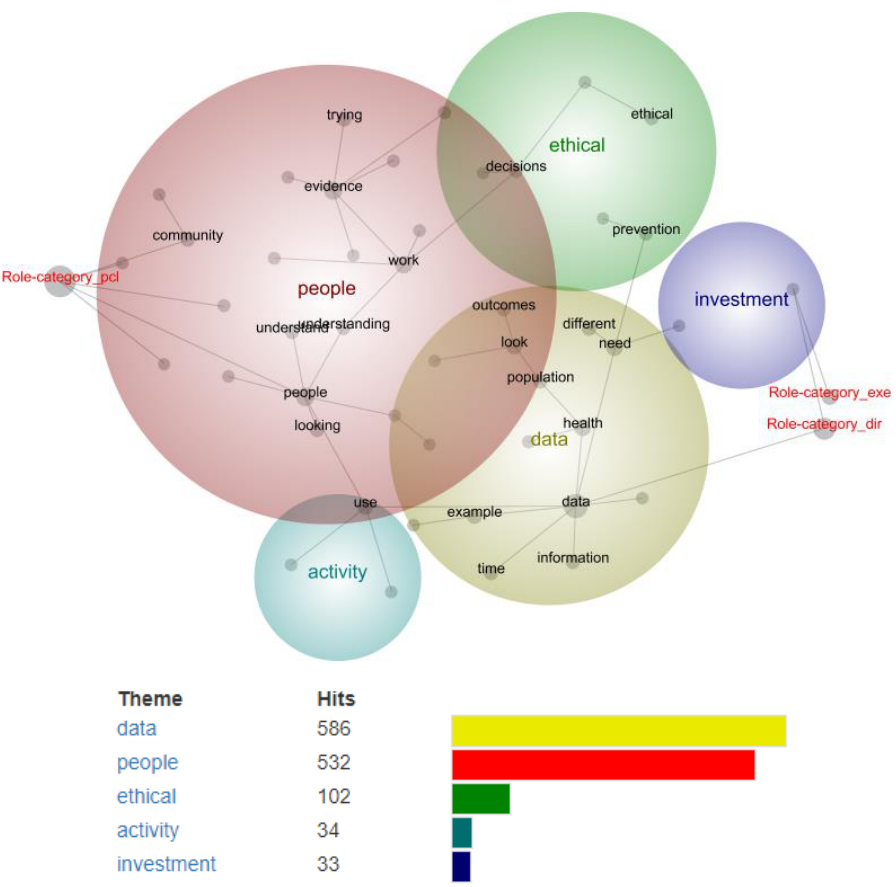
Figure 4. Concept map from Leximancer data analysis stratified by role category (Exe, Dir, PCL).